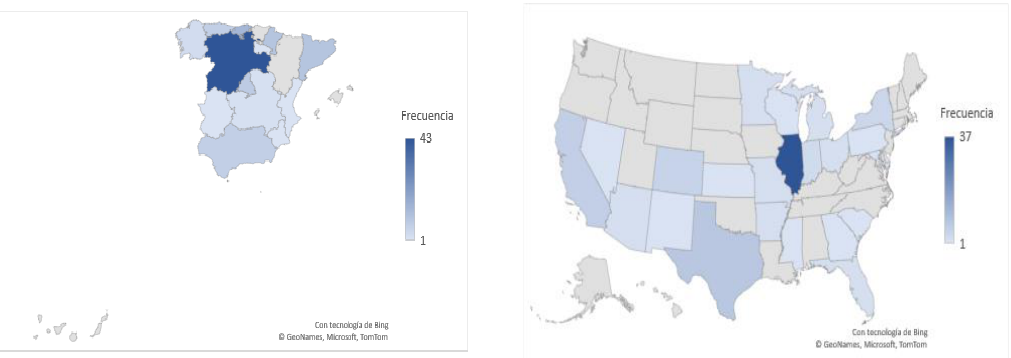
Figure 2. Distribution of the participants by autonomous community and state.